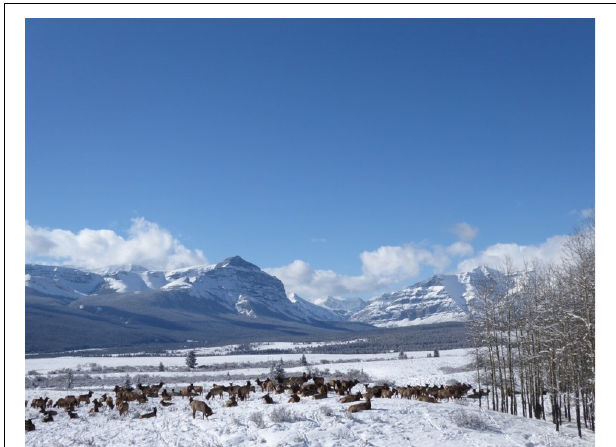
FIGURE 1 | North American elk ( Cervus canadensis ) on the Ya Ha Tinda winter range adjacent to Banff National Park, Alberta, Canada, with permission from Camille